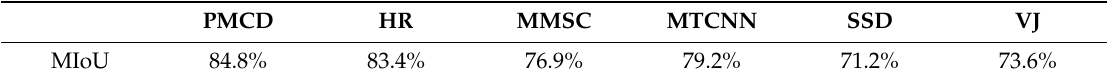
Table 1. Mean intersection over union (MIoU) on the self-collected dataset.